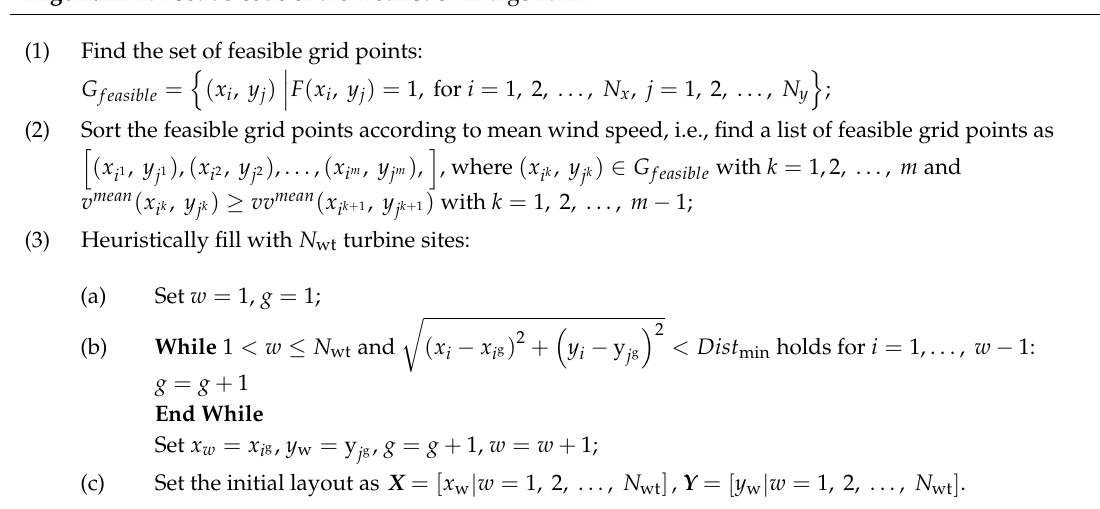
Algorithm 1. Pseudo code of the Heuristic Fill algorithm.